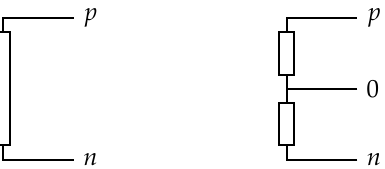
Figure 2. Examples of C-type and E-type